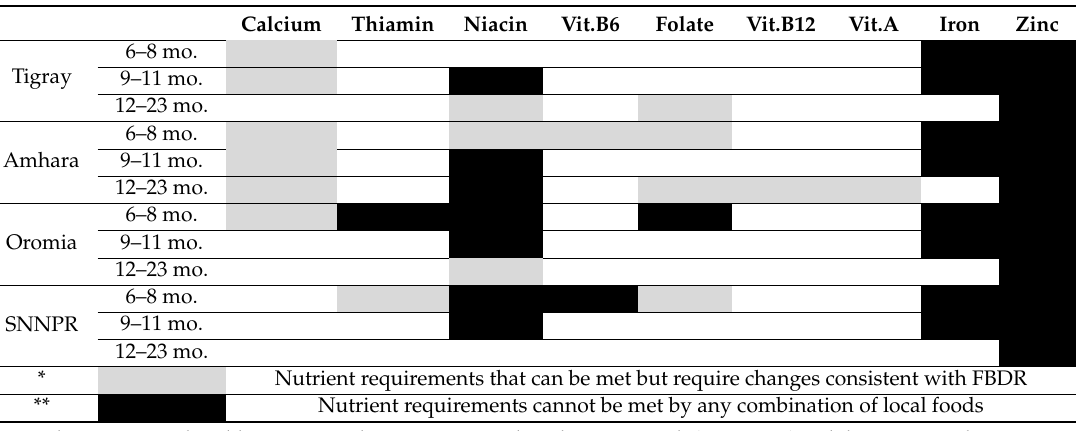
Table 3. Summary of problem nutrients in young children’s diets that can be solved with food-based dietary recommendations and those persisting, by age group and region.